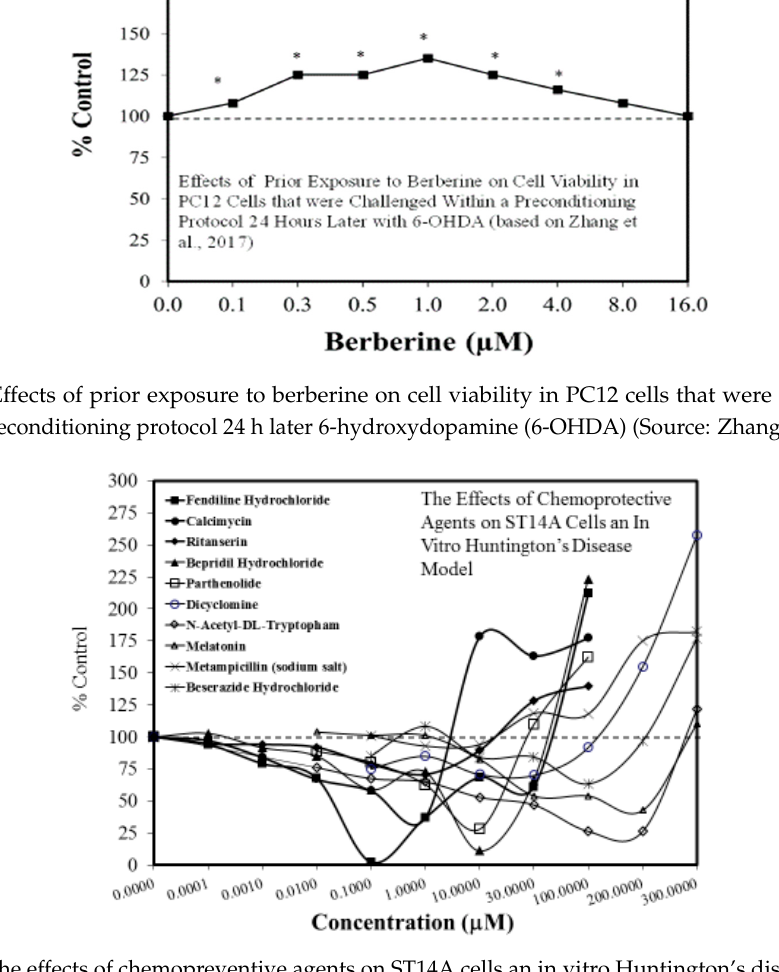
Figure 8. The effects of chemopreventive agents on ST14A cells an in vitro Huntington’s disease model (Source: Wang et al. [63]-Table S1). Protection occurs in responses <100%, whereas toxicity occurs for responses >100%.